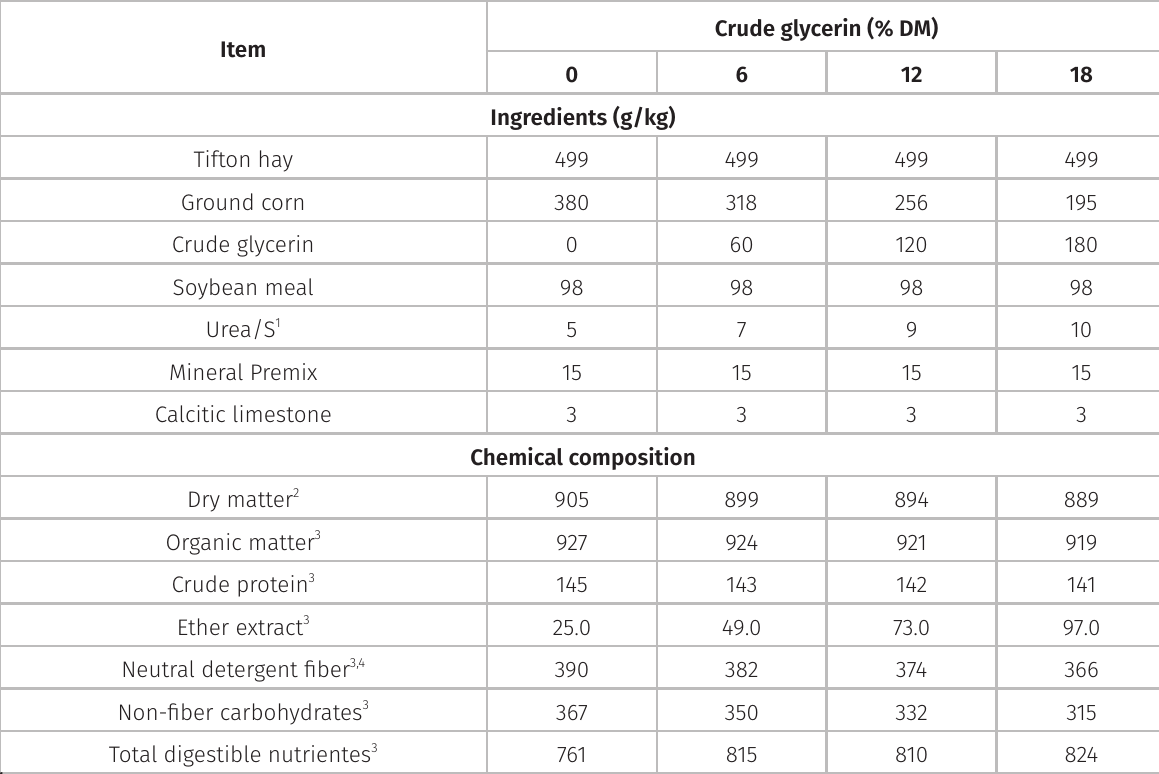
Table I. Proportion of ingredients and chemical composition of the experimental diets.